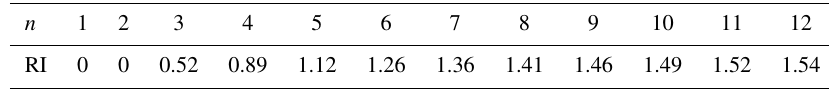
Table 1. The random average consistency index.